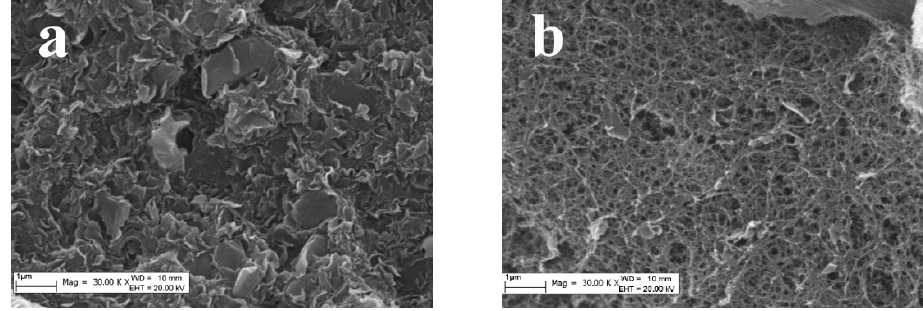
Figure 5. SEM images of the ( a ) xerogel and ( b ) aerogel.